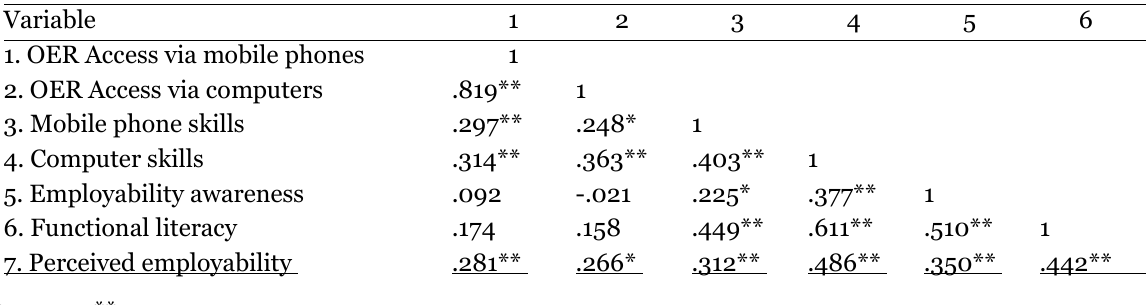
Zero-Order Correlations Among the Variables